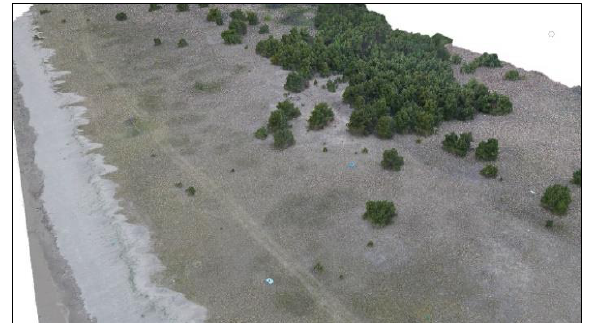
Figure 6. 3D photo of Jinu-do using RealityCapture.